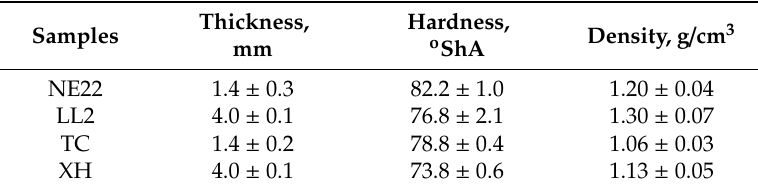
Table 1. Physical properties of